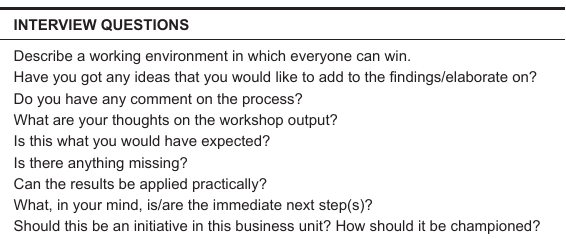
TABLE 8 Interviews with leadership